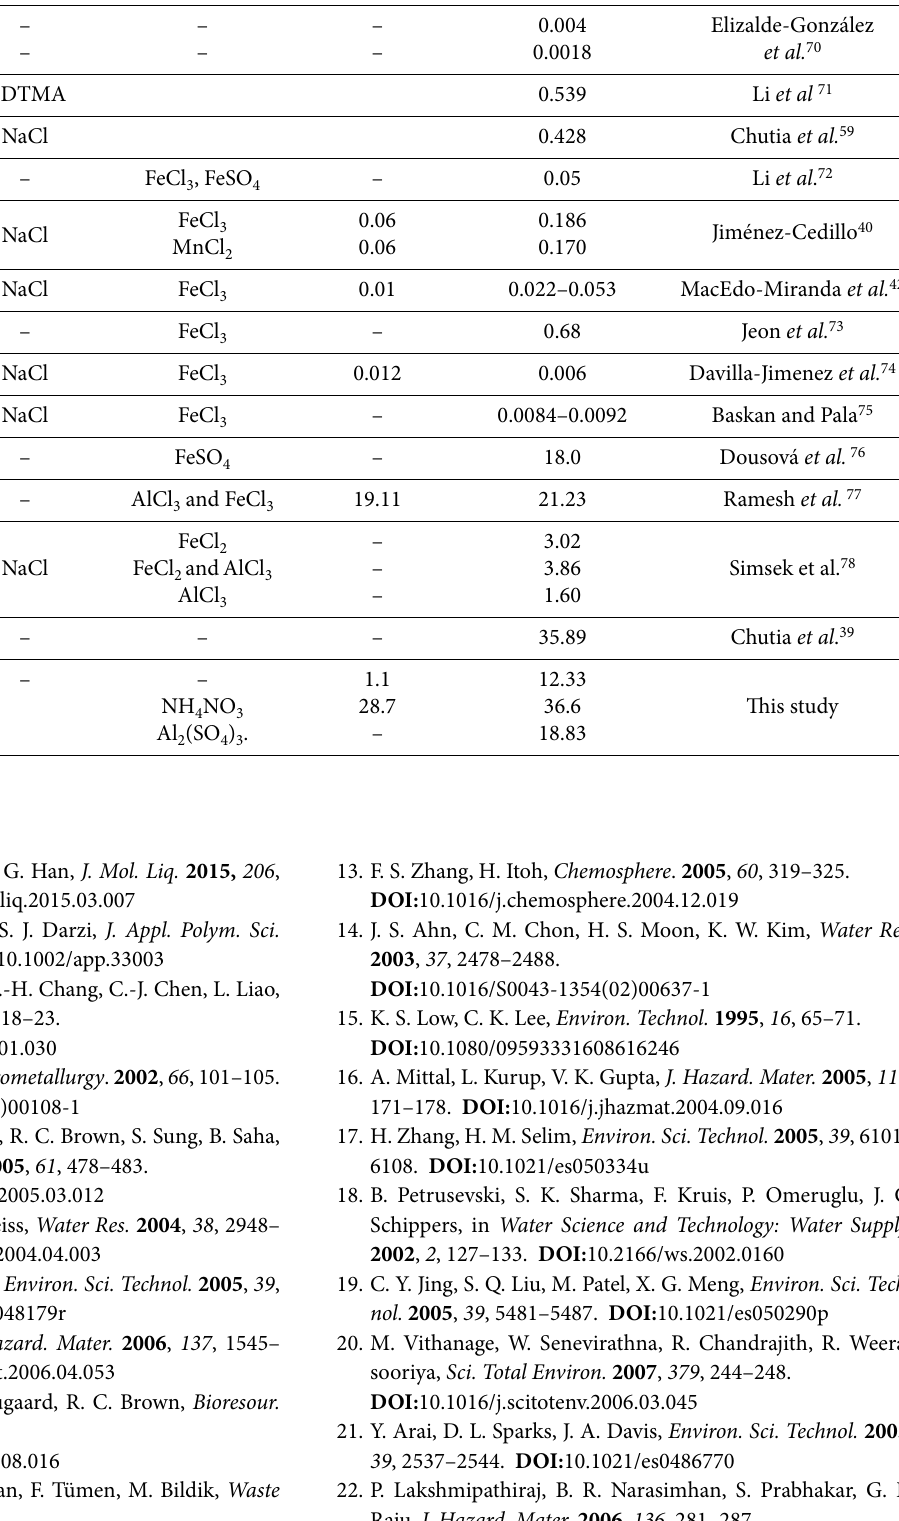
Table 7. Comparison of adsorption capacities of different types of zeolites